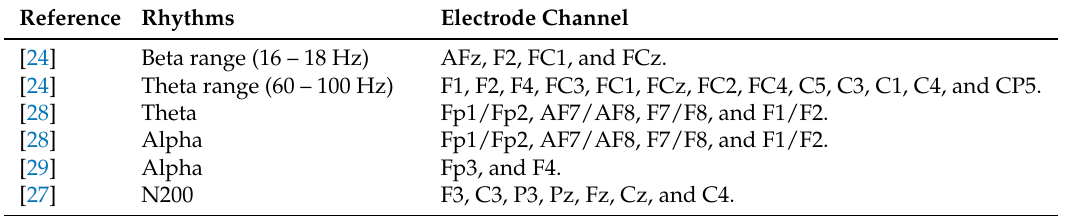
Table 3. Common rhythms/ERP and electrode positions used for the preference detection in neuromarketing. Reference Rhythms Electrode